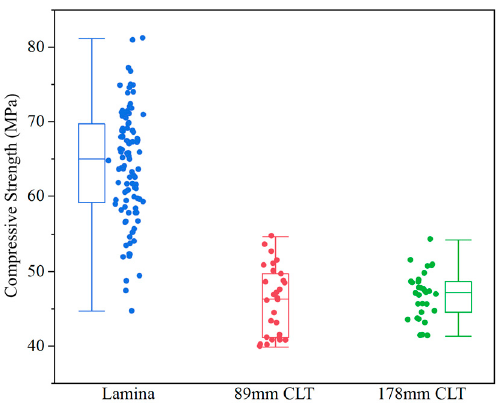
Figure 3. Results of the compressive strength test for the lamina and CLT samples with two different widths.